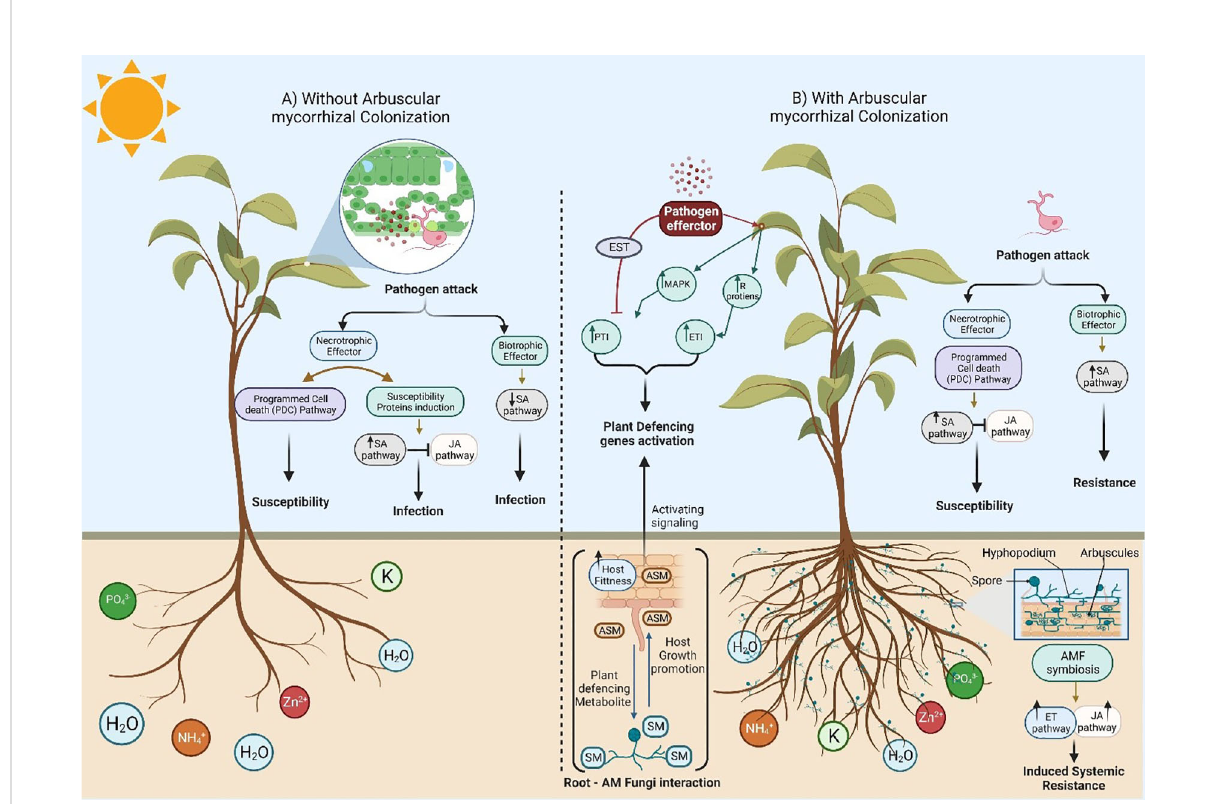
FIGURE 1 A schematic diagram to show the different plant responses against pathogenic fungi in the absence and presence of Arbuscular mycorrhizal fungi (AMF) colonization. (A) Absence of root colonization by AMF causes more damage when compared to mycorrhizal plants due to the development of symptoms in response to necrotrophic and biotrophic pathogens. In addition, host plants with undeveloped root systems have a low ability to uptake nutrients from the soil, leading to plant death by the end. (B) A symbiotic relationship between plant roots and Arbuscular mycorrhizal fungi (AMF) signi fi cantly alters ecosystems and impacts plant production via plant growth promotion due to improved acquisition of mineral nutrients through the extensive AM fungal hyphal network (mycorrhizosphere) with a massive mycorrhizal network around the root system. Furthermore, host plants can thrive under various abiotic/biotic stresses (including drought, salt, herbivory, temperature, metals, and pathogens) due to the symbiotic localization of Arbuscular mycorrhizal fungi (AMF) via complex signal communications that increase the photosynthetic plant rate. Hence, the release of strigolactones (SLs) as part of the root exudates induces the branching of AMF hyphae to promote mycorrhization. Changes in the root exudate patterns induce changes in the soil microbial community, possibly by attracting antagonists of pathogens. In addition, there are various ways of AMF-induced biotic stress tolerance in plants via competition with soil pathogens and nutrients uptake, altered root exudates which support bene fi cial microbes and suppress phytopathogens in the rhizosphere, AMF colonized roots have little or no space for pathogen entry. Interestingly, a general reduction in the damage and incidence of disease caused by soilborne pathogens was noticed due to defense power from the priming of the plant. The role of the phytohormones (e.g., JA and ET) in the relationship between the host plant and its symbiotic fungi are well known. Phytohormones participate as signaling molecules and improve host plant ISR (Induced Systemic Resistance). In contrast, the development of necrotrophic pathogens in plant – fungal pathogen interaction signals is restricted due to the primed jasmonate-regulated plant defense